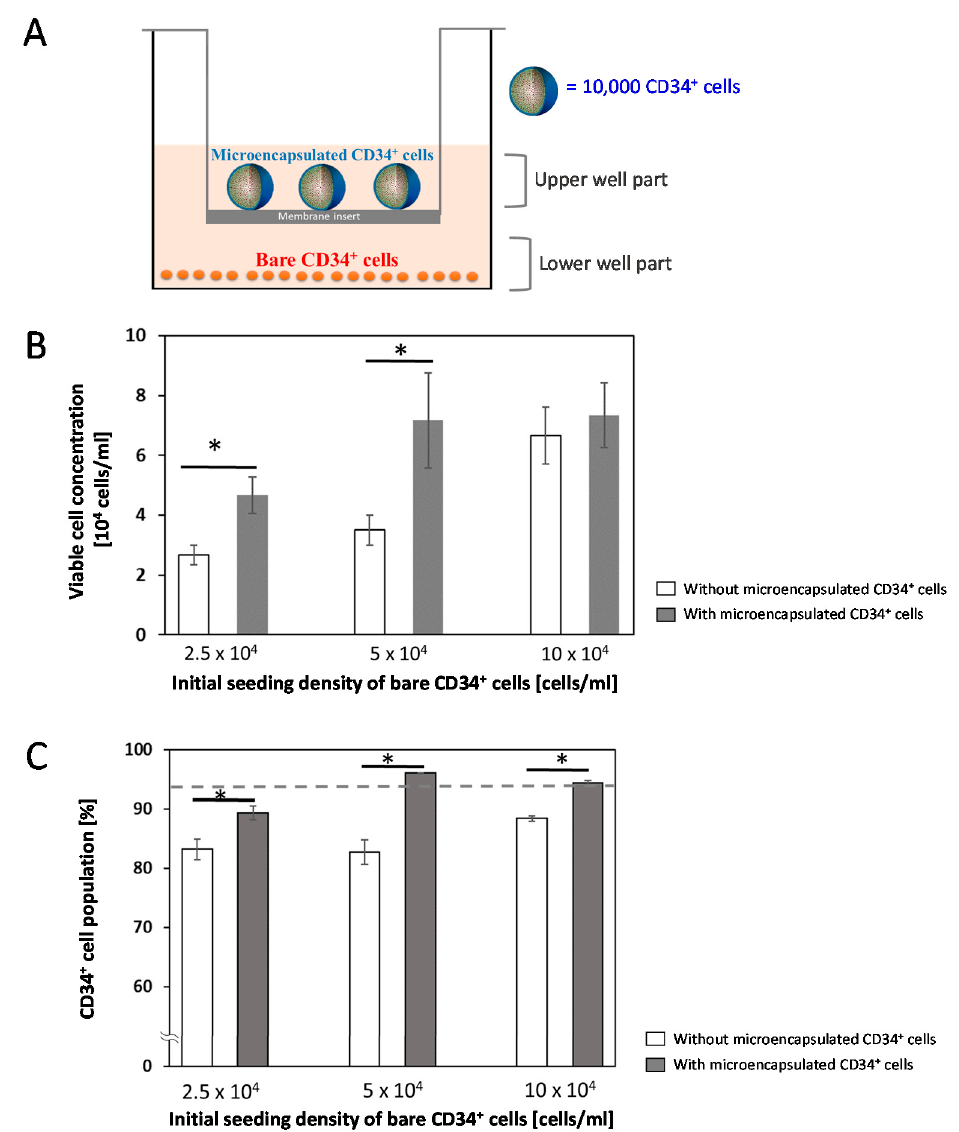
Figure 2. ( A ) Illustration of co-culture system of CD34 + cell-loaded microcapsules (3 × 10 4 cells/well) with bare CD34 + cells from unrelated donors. ( B ) Viable cell concentrations of bare cells (lower well) on day 8. ( C ) Ratio of CD34 + cell population (lower well) on day 8. Striped line in C indicates percentage of CD34 + cell population on day 0. Asterisks (*) in ( B , C ) indicate p <